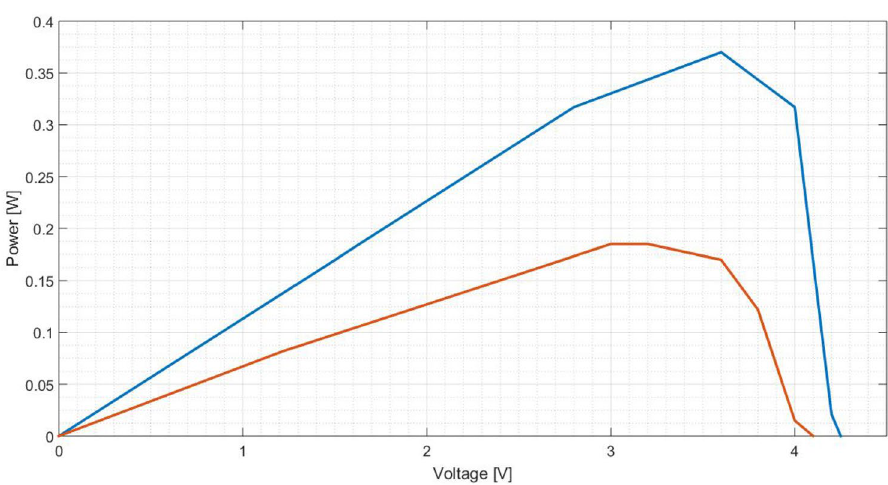
Figure 26. Comparison between P(V) curves of pure aluminium plates (Blue: Day 0; Red: Day 30).